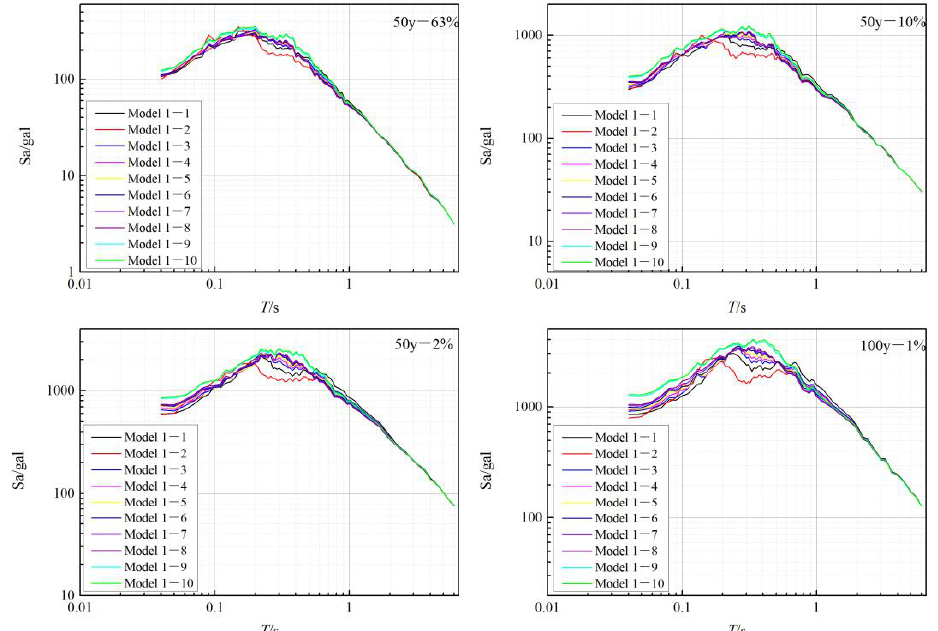
Figure 6. Spectral accelerations for the different thicknesses of pebble layer under four seismic inputs.